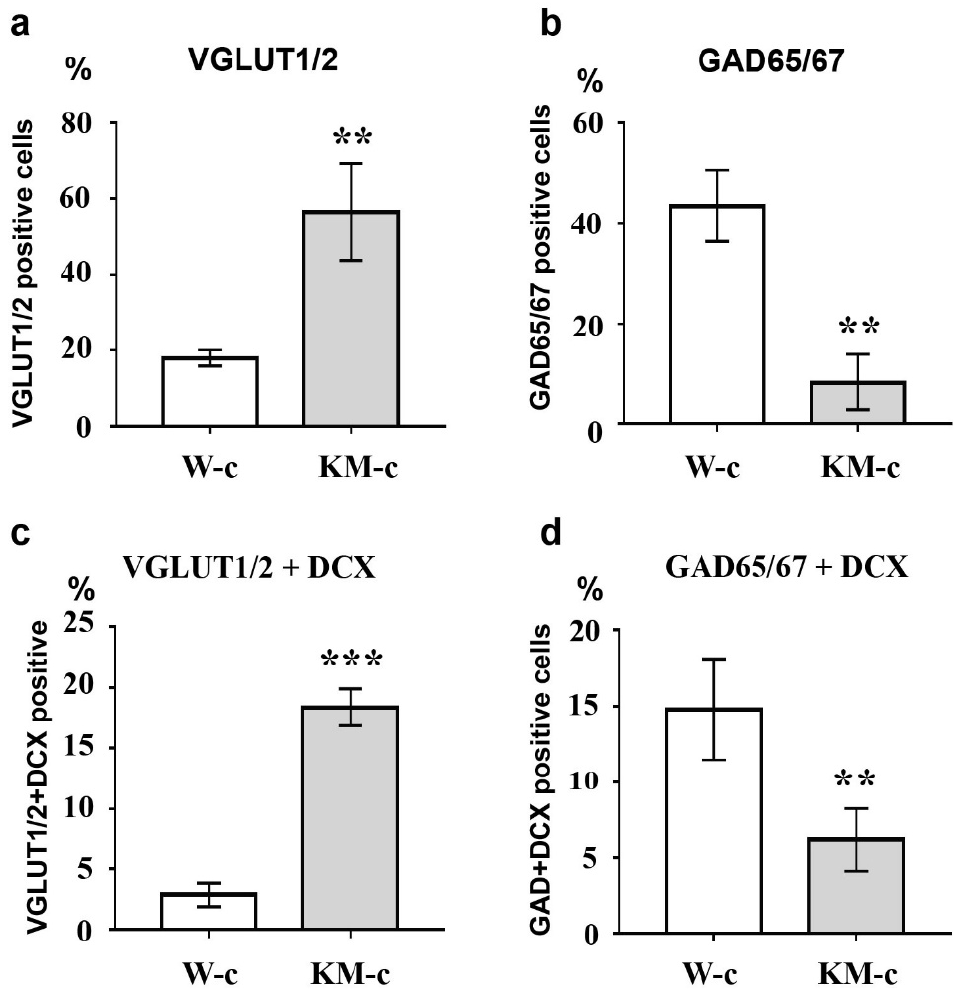
Figure 2. Analysis of VGLUT1/2, GAD65/67, and doublecortin (DCX) expression in control cultures of NPC. Control culture of KM NPC (KM-c) demonstrated increased numbers of VGLUT1/2- ( a ), and VGLUT1/2/DCX-double positive ( c ) cells in comparison with control Wistar NPC culture (W-c). In contrast, percentages of GAD65/67-positive ( b ) and GAD65/67/DCX-double positive ( d ) cells were higher in control Wistar culture. Axis x : experimental groups. Axis y : number of immunopositive or double immunopositive cells as % of the whole cell number calculated with use of DAPI-stained cell nuclei. The data are calculated from three independent experiments. Results are shown as mean ± SD. Significant differences from control: ** p < 0.005, *** p < 0.001.